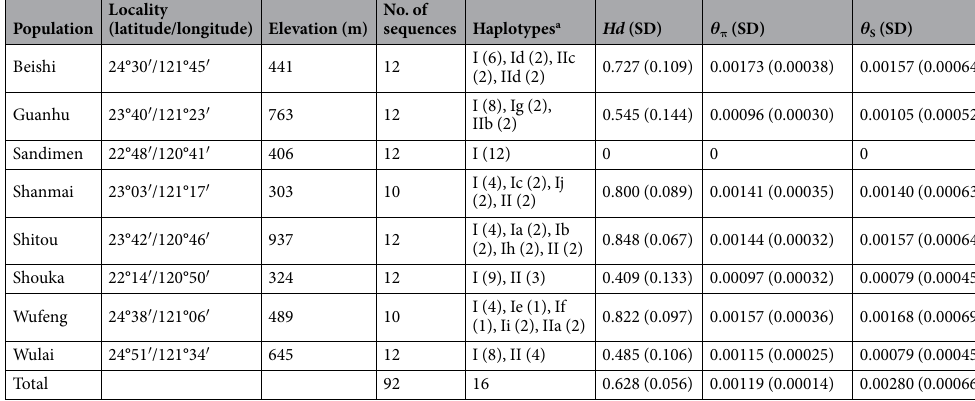
Table 1. Population, localities, and descriptive statistics of Musa basjoo var. formosana based on the second intron sequences of Cu/Zn SOD2. Hd , haplotype diversity; θ π , nucleotide diversity estimated based on the average pairwise number of differences between sequences, θ S , nucleotide diversity estimated based on the number of segregating sites per sequence. a The numbers in parentheses indicate the frequency of